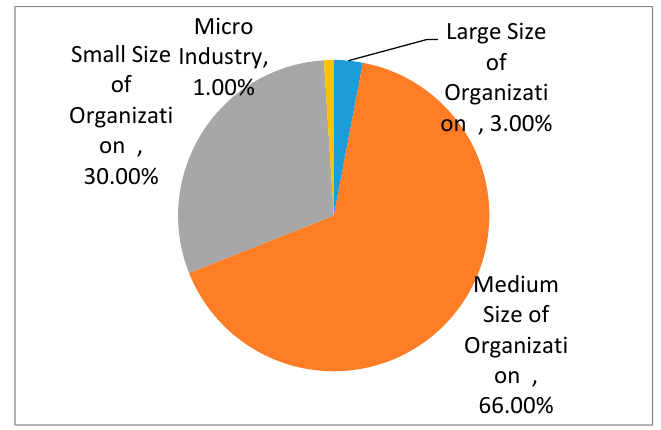
Figure 6. Size of industries used as a sample.